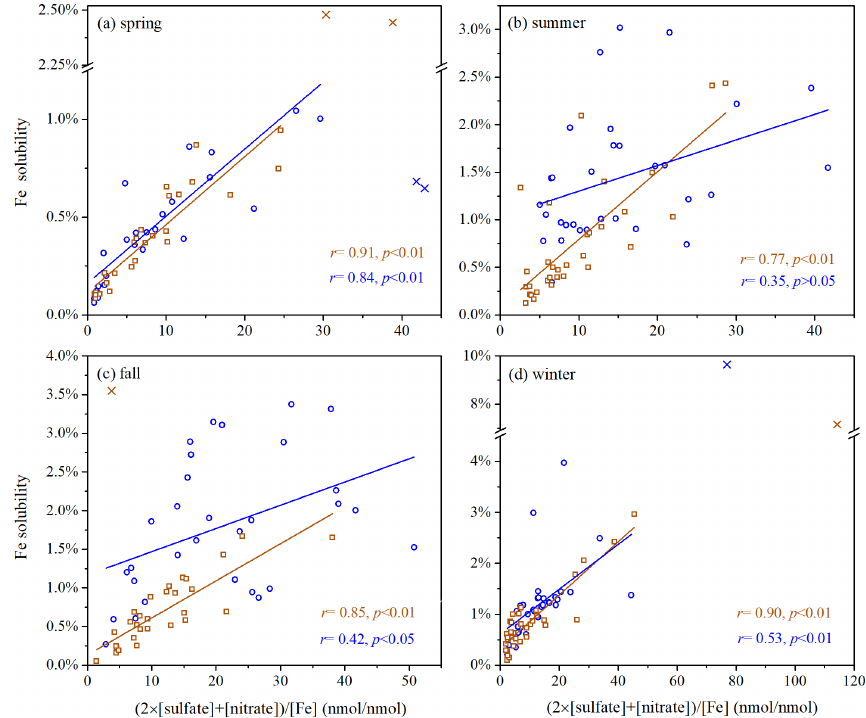
Figure 7. Fe solubility versus (2 × [sulfate] + [nitrate]) / [Fe] for fine and coarse particles in different seasons: (a) spring; (b) summer; (c) fall; (d) winter. Blue symbols represent fine particles, and brown symbols represent coarse particles. Cross symbols represent data points which are not included in fittings.